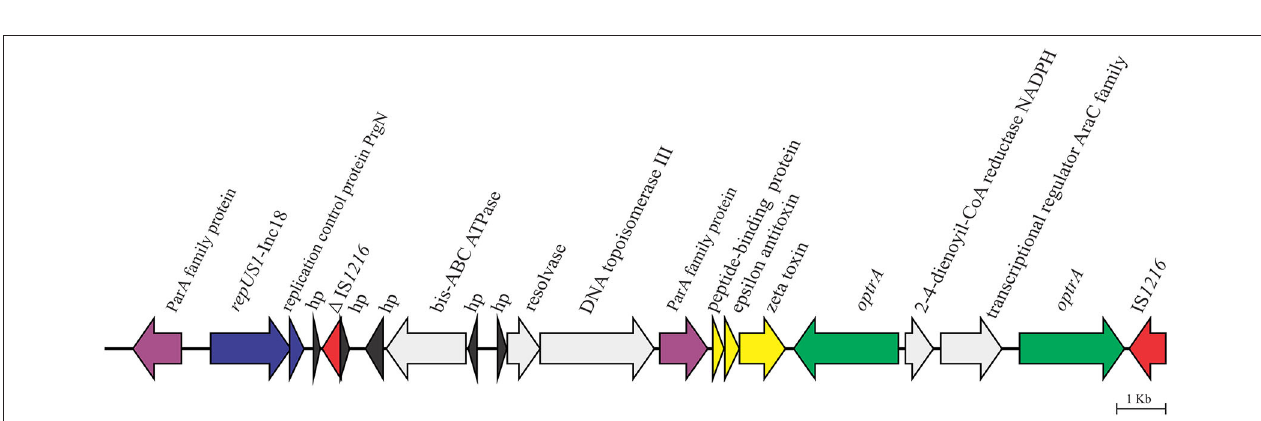
FIGURE 2 | Genetic context of the 58,593-bp optrA -carrying partial sequence pL9 (CP041776.1) in the porcine LR E. faecalis isolate L9. duplication of optrA ( Figure 2 ). The ω - ε - ζ TA module, a 5 ′ TGATGGTAATATGGTGTTGGAA3 ′ . Further analysis of pL9 post-segregational killing system which acts at cell division showed the presence of genes coding for the zeta–epsilon– eliminating progeny that fails to inherit plasmid copy, delta ( ω - ε - ζ ) toxin–antitoxin (TA) system upstream of the